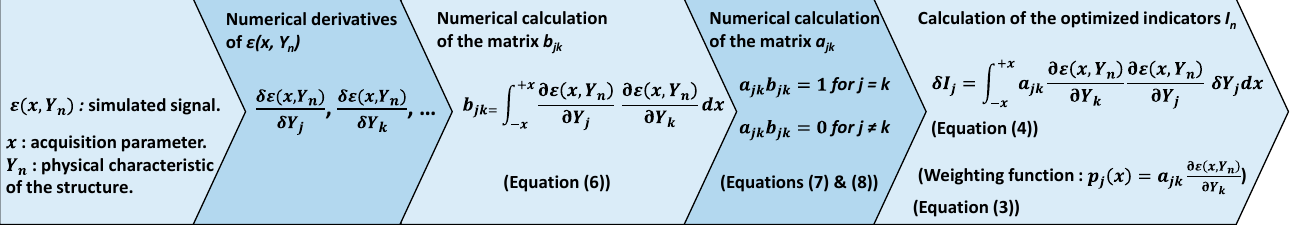
structure parameter.